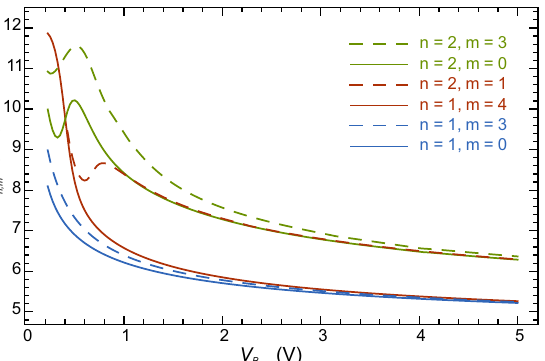
Figure 8. Average wave-function radius of several low-order eigenstates of model 1 vs. bias voltage. Full lines: Eigenfunctions symmetric with respect to Ox and Oy . Dashed lines: eigenfunctions symmetric to Ox and antisymmetric with respect to Oy